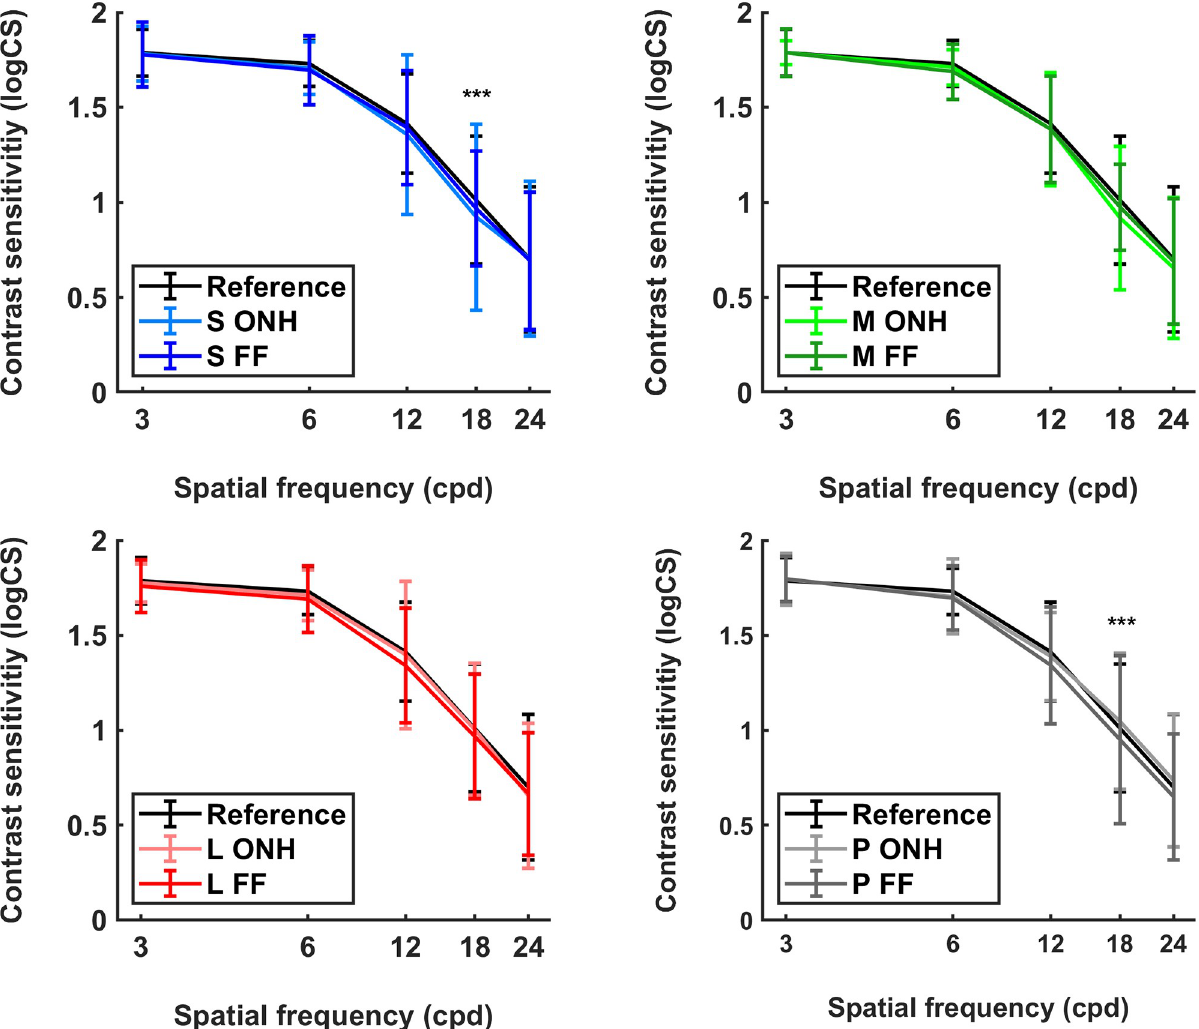
Fig 4. Contrast sensitivity in logCS (median and interquartile range) before (Reference) and after stimulation under different conditions: S ONH (short-wavelength range at optic nerve head), S FF (short-wavelength range via screen full-field), M ONH (middle-wavelength range at optic nerve head), M FF (middle-wavelength range via screen full-field), L ONH (long-wavelength range at optic nerve head), L FF (long-wavelength range via screen full-field), P ONH (polychromatic light at optic nerve head) and P FF (polychromatic light via screen full-field) (n = 30; ��� p <